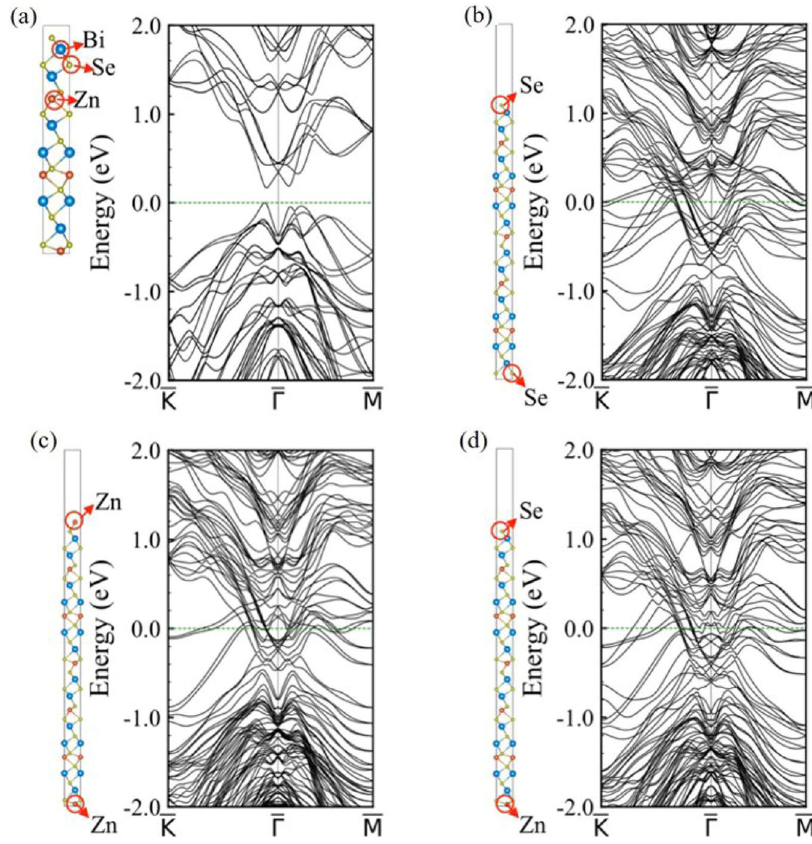
Fig. 7 Theoretical calculations of spin-orbit coupling (SOC) band structure of Zn 2 + intercalated in Bi 2 Se 3 interlayers. a Illustration of the supercell for modeling Zn 2 + intercalated in Bi 2 Se 3 interlayers (here denoted as Zn 2 + Bi 2 Se 3 ) and the correspondent SOC band structure. b – d SOC band structures of Zn 2 + Bi 2 Se 3 6-QL slab model with Se-Se ( b ), Zn-Zn ( c ), and Se-Zn ( d ) surface Fig. 31. A bandgap exists in the bulk, and the results obtained through the calculation for the 6-QL slab model display surface metallicity; the conductivity of Zn x Bi 2 Se 3 bene fi ts from metallic surface states, as proposed in the schematic plot of Supplemen- tary Fig. 32.